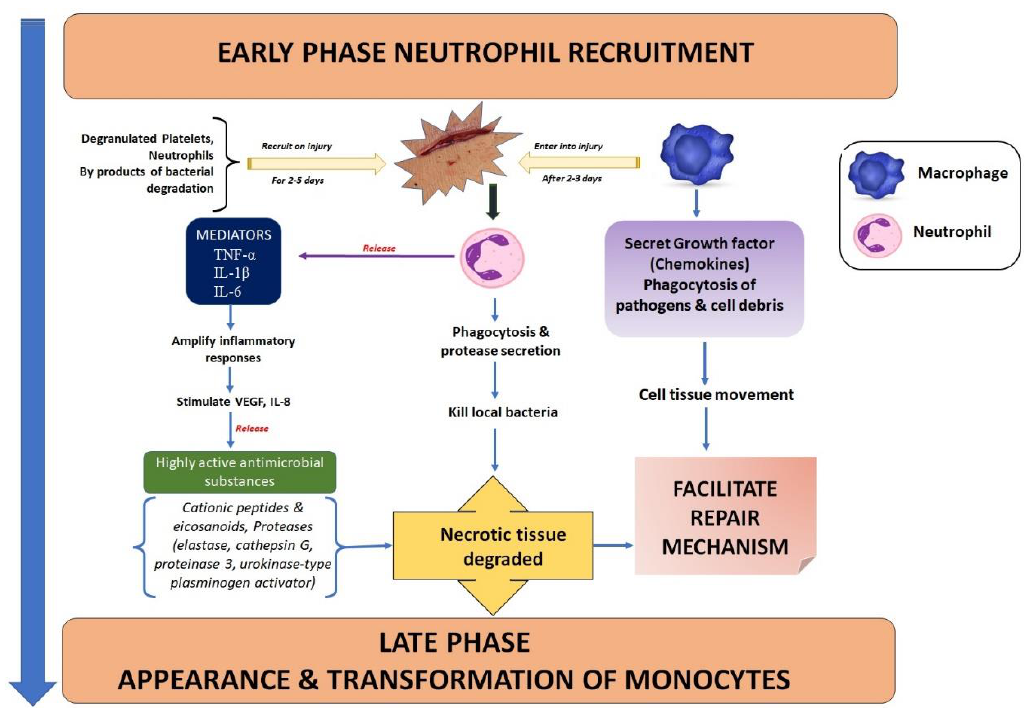
Figure 3. Inflammatory phase following a cutaneous incision. Inflammatory cell invasion: Early inflammatory phase activates the complement cascade and initiates molecular events while in the late phase, macrophages appear in the wound and continue the process of phagocytosis.